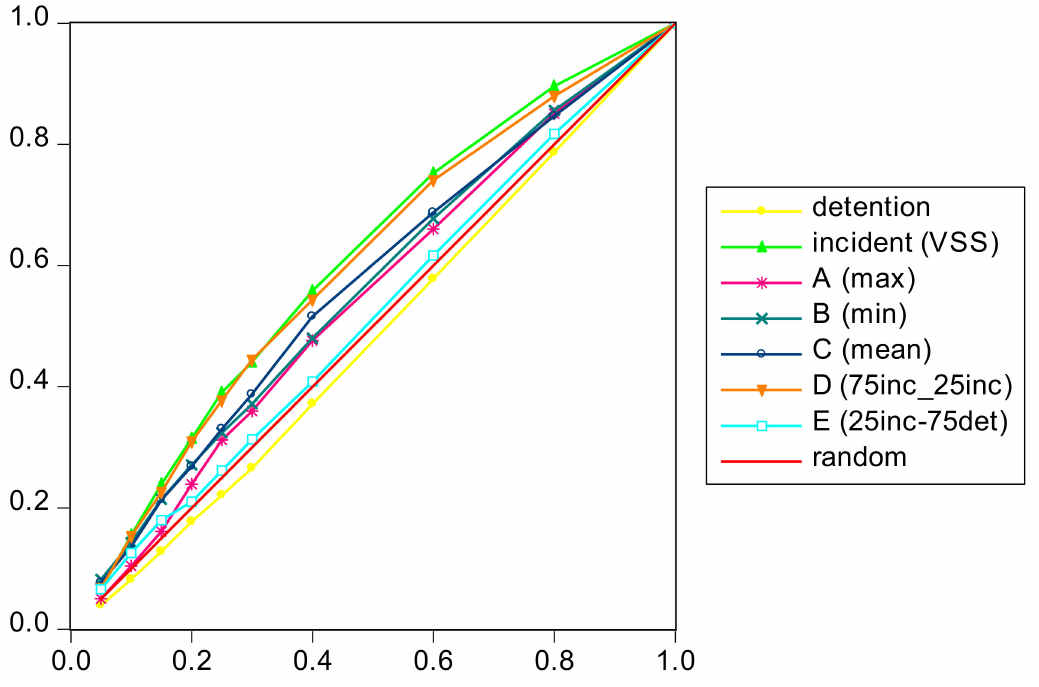
Figure A1. ROC curve—evaluation variable incidents (VSS): total incidents 756.